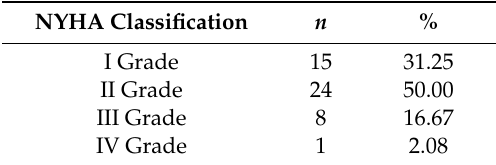
Table4. FunctionalclassofheartdiseaseaccordingtoNewYorkHeartAssociation(NYHA)classification ( n =